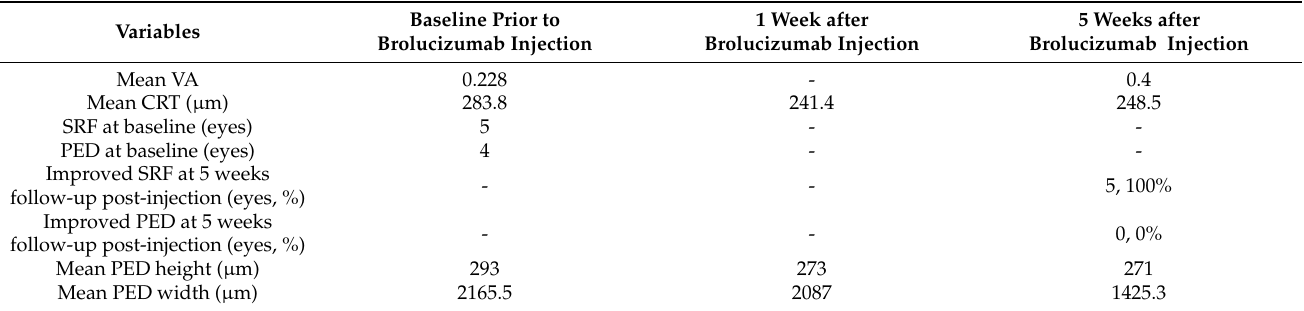
Table 3. Anatomical and visual outcomes in wAMD patients at baseline before injection, 1 week and 5 weeks post-injection (wAMD only: n =